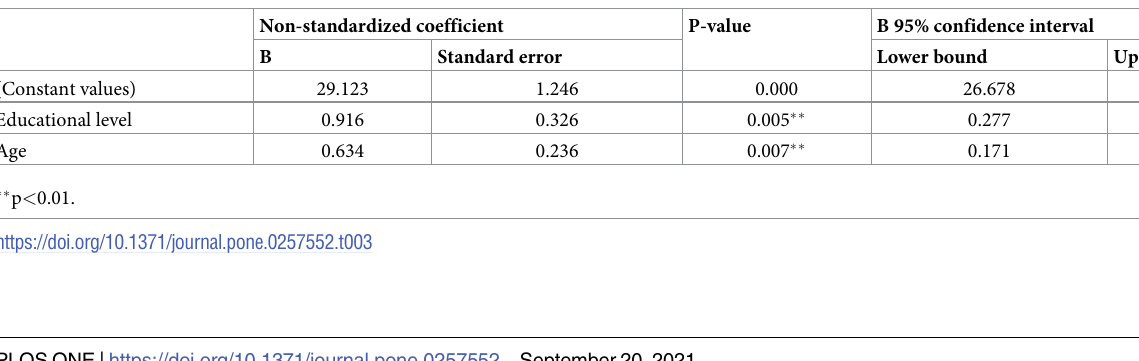
Table 3. Multivariate linear regression analysis of health literacy, predictive